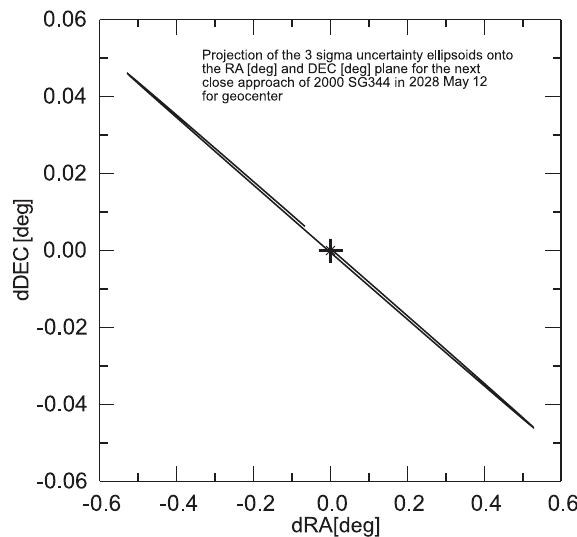
Fig. 2. Asteroid 2000 SG344. Projection of the 3 (cid:27) uncertainty ellipsoid onto the RA and DEC plane for the next close approach of 2000 SG344 in 2028 May 12 for geocenter. Table 6. Asteroid 2000 SG344. Keplerian orbital elements with their uncertainties for the epoch JD2457200.5 = 2015 June 27 for (cid:12)ve clones. Semimajor Eccentricity Inclination Longitude